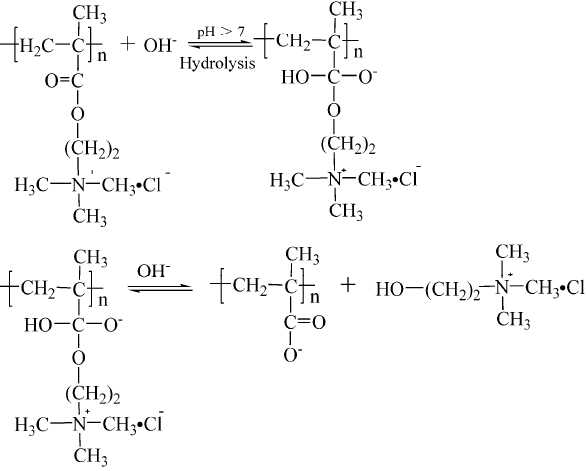
Figure 19. Base-catalyzed ester hydrolysis mechanism of PDMC.